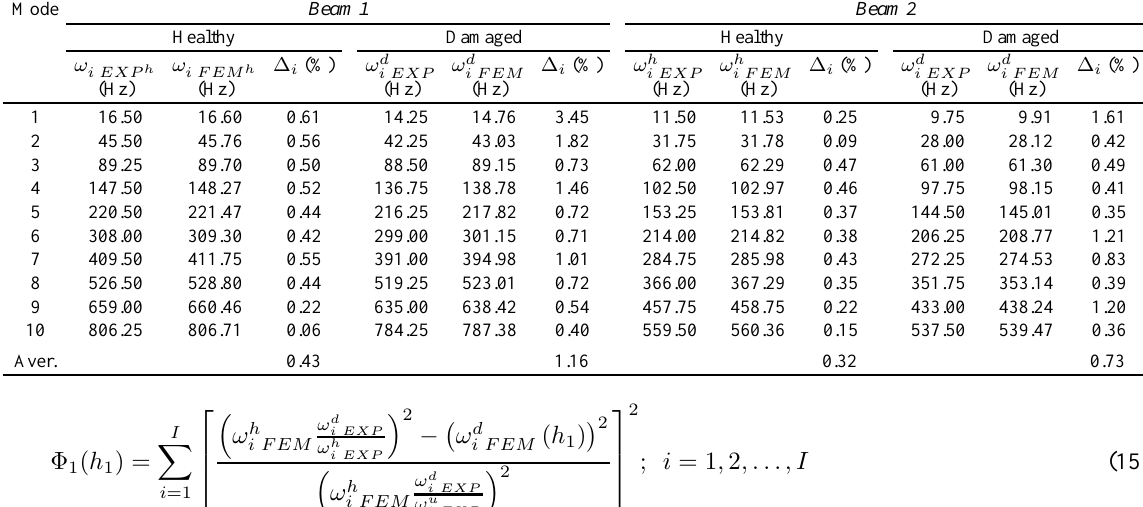
Table 1 Flexural frequencies and residuals for the Beam 1 and the Beam 2 with FF boundary